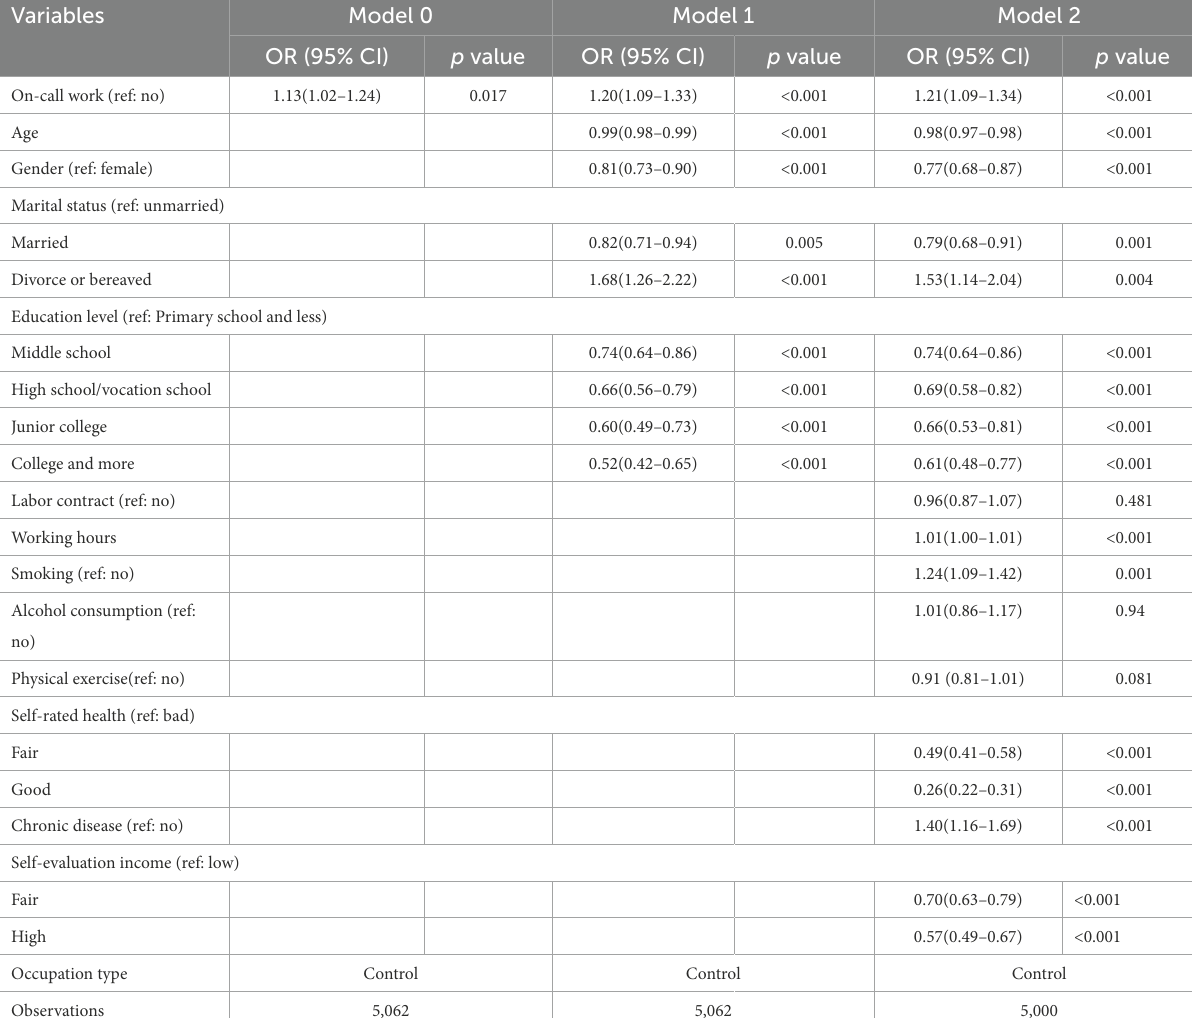
TABLE 3 Ordered logistic regression of on-call work and depressive